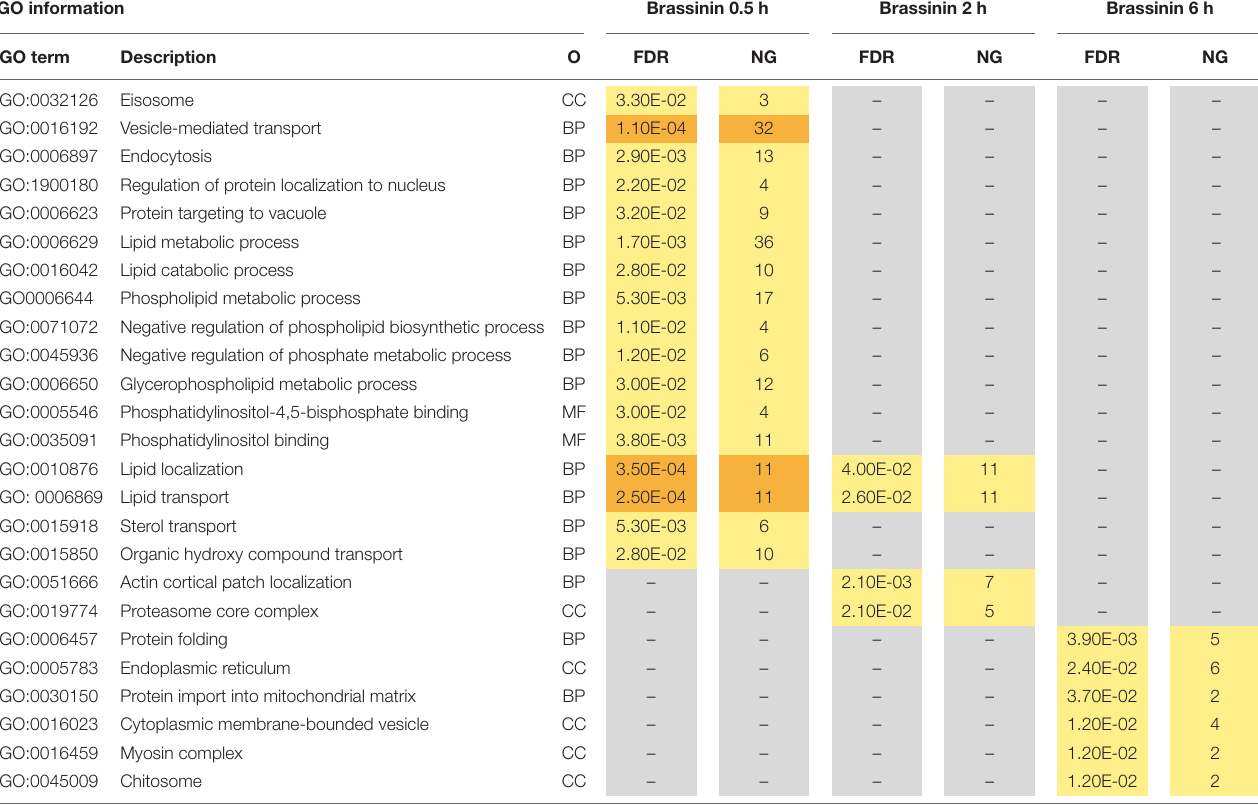
TABLE 2 | Gene ontology (GO) enrichment analysis on up-regulated genes related to brassinin